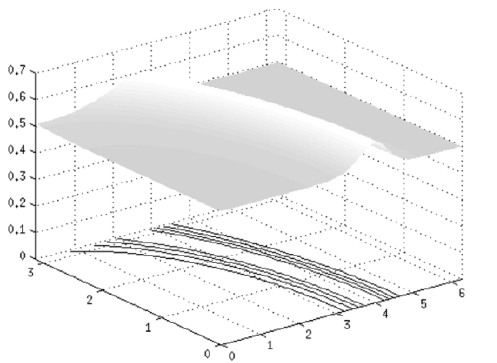
Figure 9. Illustration of surface described by function G(x) .